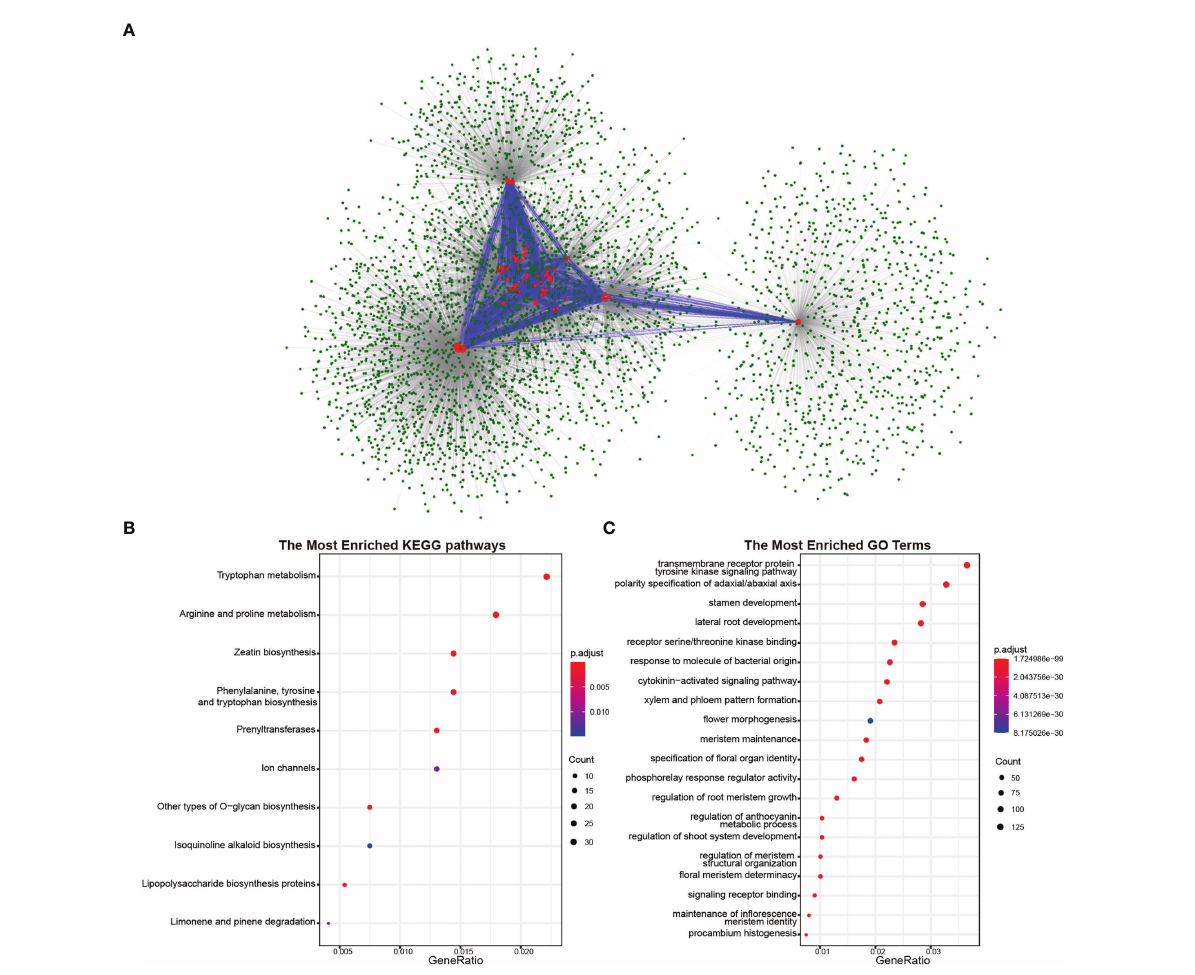
FIGURE 6 Proteins interacted with CLE proteins in Brassica napus. (A) Protein – protein interaction network of CLE proteins in B. napus. The red circles represent the CLE proteins, and the green circles represent proteins interacting with CLE proteins. The blue lines represent the interaction between CLE proteins, and the gray lines represent the interaction between CLE proteins and other proteins. (B) Kyoto Encyclopedia of Genes and Genomes (KEGG) pathway enrichment analysis of proteins interacted with CLE proteins. (C) Gene Ontology enrichment analysis of proteins interacted with CLE